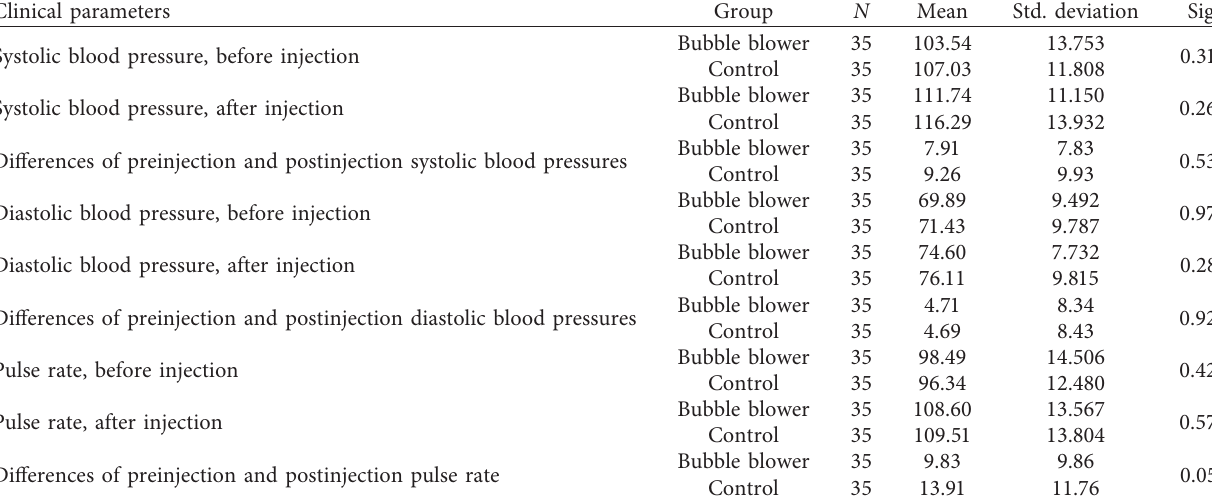
Table 1: The mean values of pulse rate and systolic or diastolic blood pressure. Clinical parameters